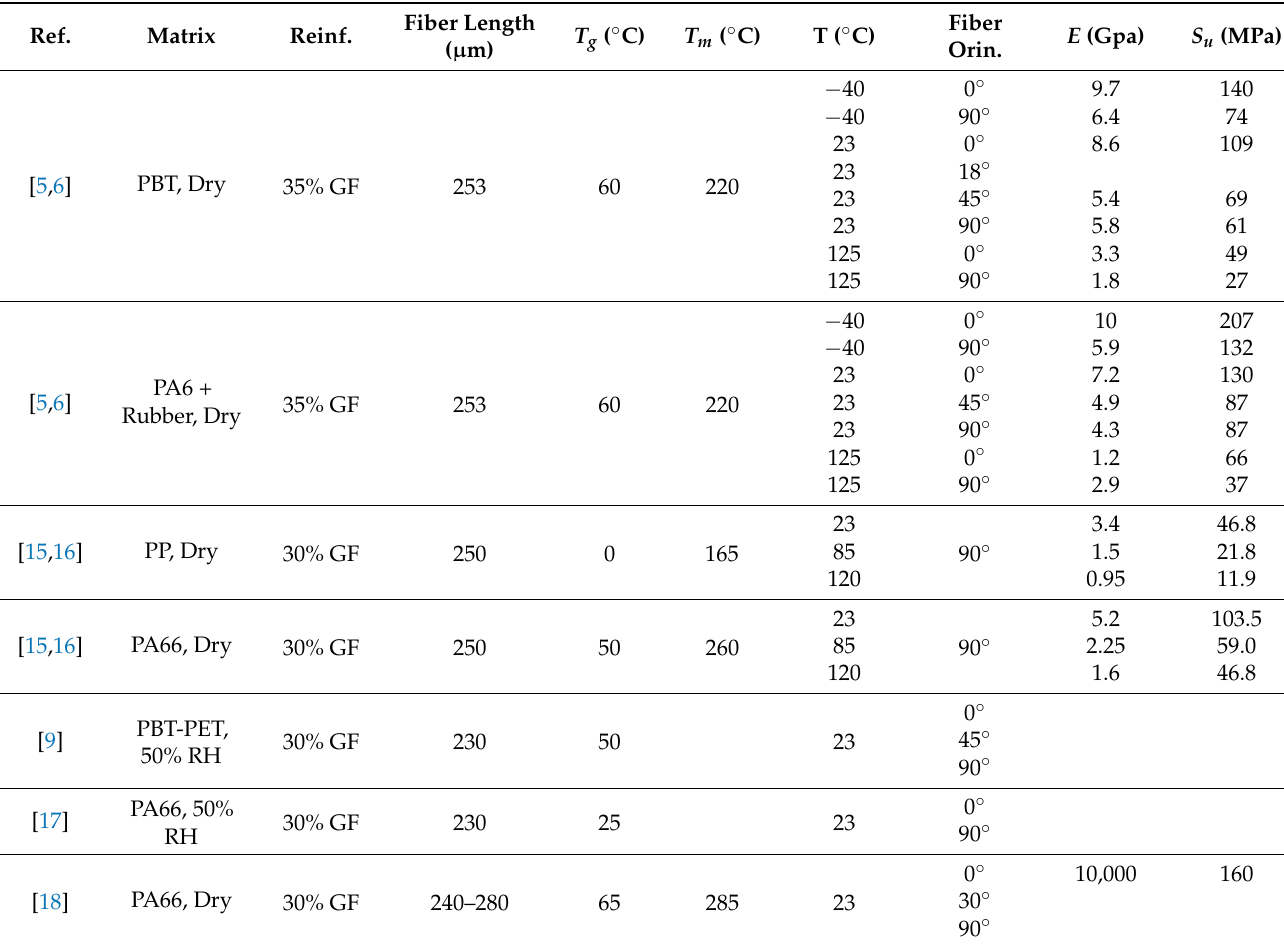
Table 1. Literature data sets for the mechanical and physical properties of injection-molded short glass fiber composites used in this study. Fiber diameter is 10 µ m. The fiber aspect ratio (fiber length/fiber diameter) range is 23–26.